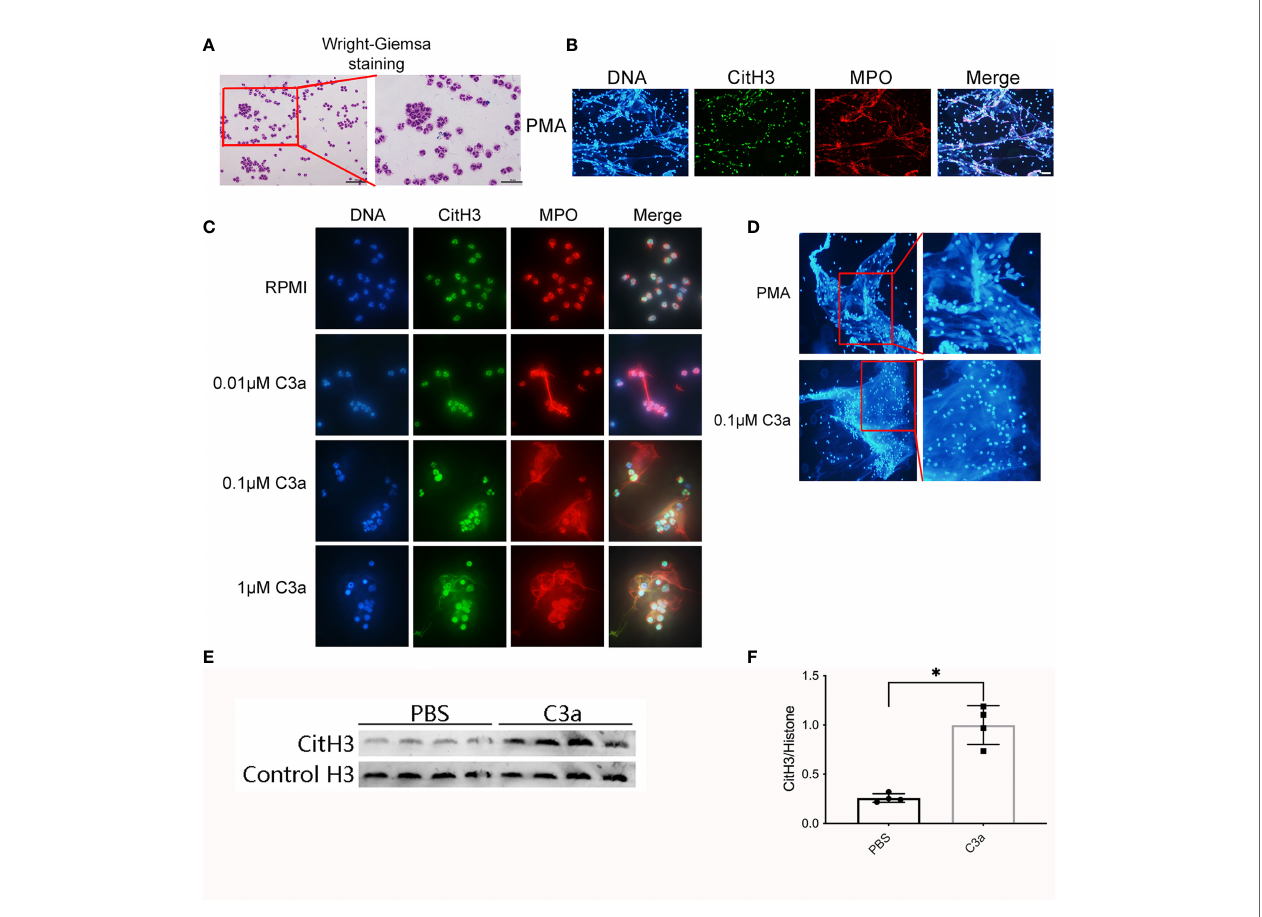
FIGURE 9 | Neutrophils release NETs in response to PMA and C3a. (A) Wright – Giemsa staining of neutrophils isolated from peripheral blood of normal individuals. Representative overlay images of NETs from human granulocytes treated with 15 nM PMA (B) , and C3a of different concentration (C) . DAPI (blue), CitH3 (green), and MPO (red). (D) The contrast diagram of “ suicidal ” and “ vital ” NETosis induced by PMA and C3a. (E) Immunoblotting analysis of CitH3 expression in neutrophil stimulated by C3a. (F) Quantitative analysis was analyzed by normalization to b -actin expression. *P < 0.05 versus